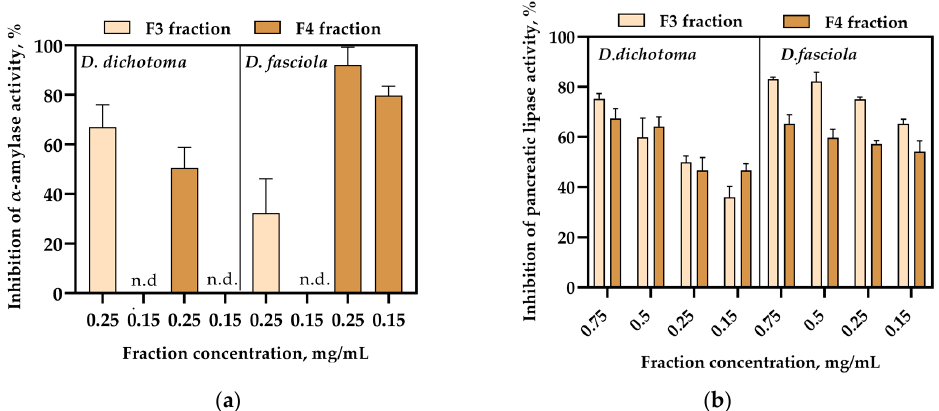
Figure 5. Enzymatic activity of D. dichotoma and D. fasciola fractions evaluated as ( a ) α -amylase inhibitory activity at the concentrations of 0.25 and 0.15 µg/mL for all fractions and ( b ) pancreatic lipase inhibitory potential at different concentrations of samples. Data are presented as mean ± SD ( n = 3). n.d. = not determined.